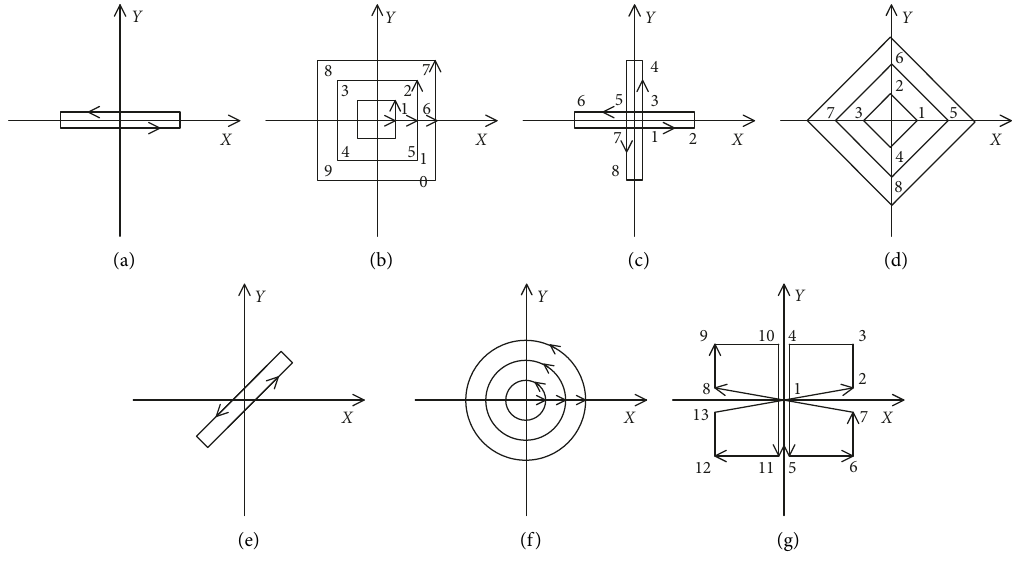
Figure 1: Loading paths